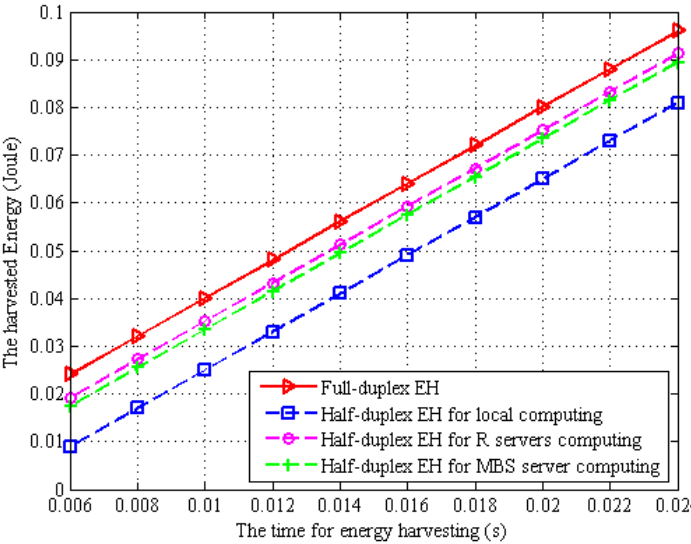
Figure 7. Energy consumption v.s. the time for